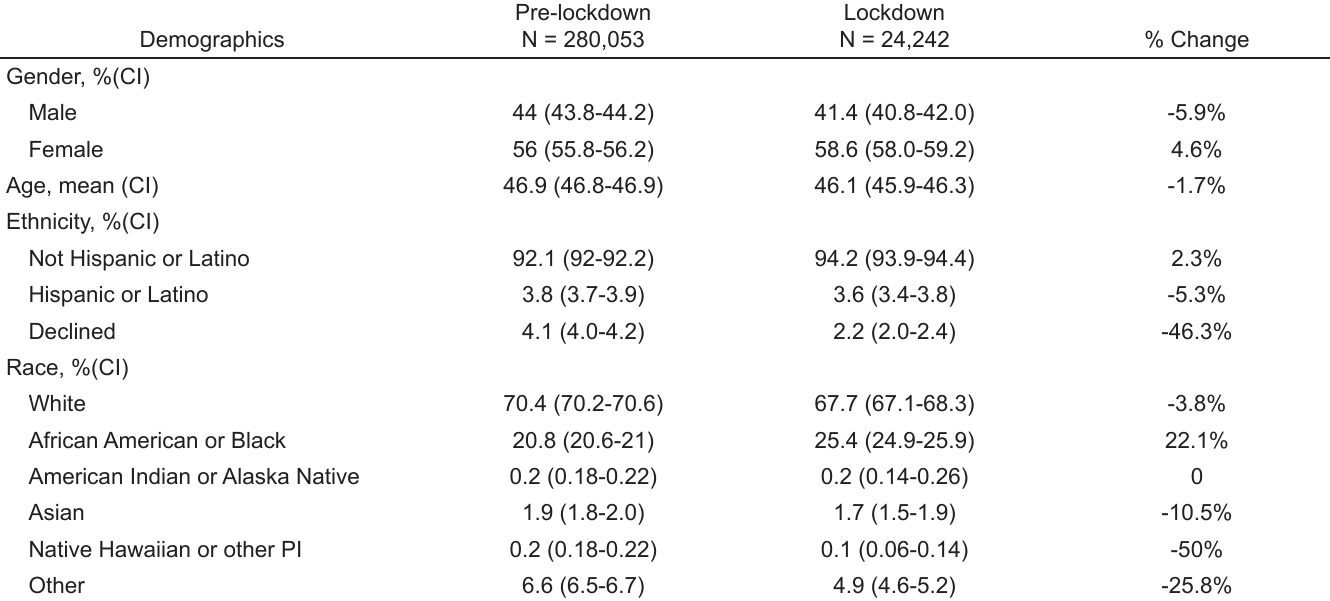
Table 5. Patient demographics pre-lockdown vs lockdown.